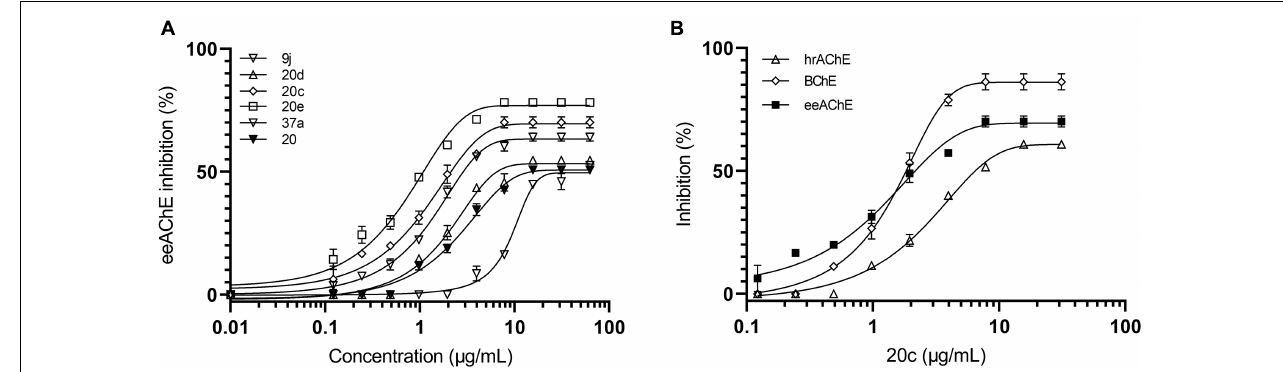
FIGURE 3 | Inhibition of cholinesterase enzymes. (A) Inhibition of eeAChE by compounds 9j , 20 , 20c , 20d , 20e, and 37a. The IC 50 values toward eeAChE were determined as 9.44 µ M for 9j , 52.7 µ M for 20 , 7.23 µ M for 20c , 35.35 µ M for 20d , 3.36 µ M for 20e and 169.54 µ M for 37a . (B) Inhibition of eeAChE, hrAChE and BChE by compound 20c. The IC 50 values toward eeAChE, hrAChE and BChE were determined to be 7.23 µ M, 22.81 µ M and 5.94 µ M, respectively.